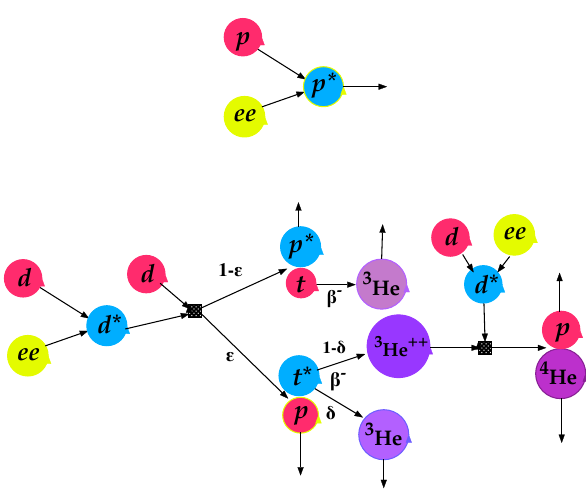
Fig. 5. An illustration showing the proton tresino formation (top), releasing 3.7keV and the deuteron tresino reaction chain (bottom) releasing 22MeV. Note that there are three deuterons “consumed” for each α particle